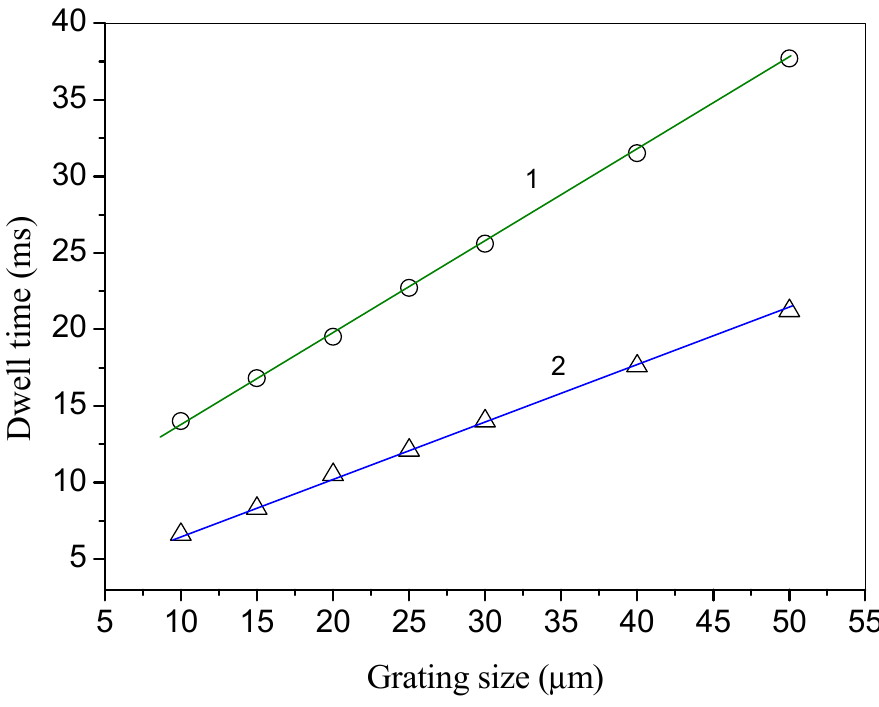
Figure 7. Dependence of the dwell time on the x-size of the calculate domain (grating size): 1 − U = 10V; 2 – U = 15V.